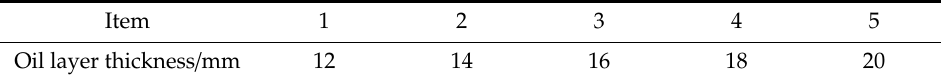
Table 3. The thicknesses of the top oil